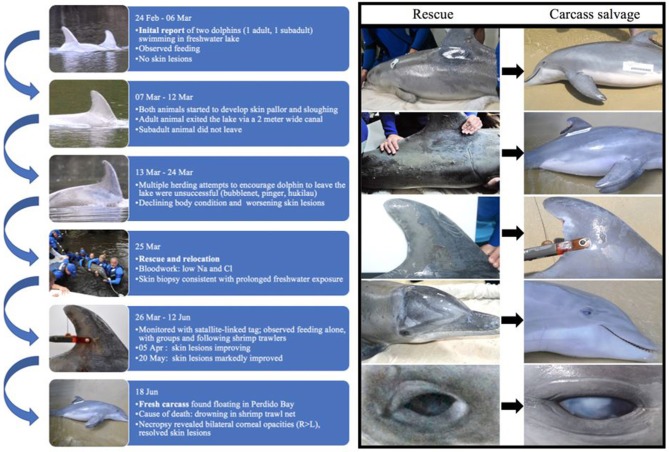
Timeline of case from initial report (24 February 2016) to time of death (18 June 2016) and photographs of skin lesions taken at time of rescue (25 March 2016; left column A–E) and time of carcass recovery (18 June 2016; right column F–J). During the 12-week period following rescue from a freshwater lake and release into a brackish water estuary, skin lesions markedly improved, with almost complete resolution. Corneal opacities were worse at time of death than at time of rescue. Left lateral body (A,F); right flank (B,G); right dorsal fin (C,H); right lateral head (D,I); and right eye (E,J).